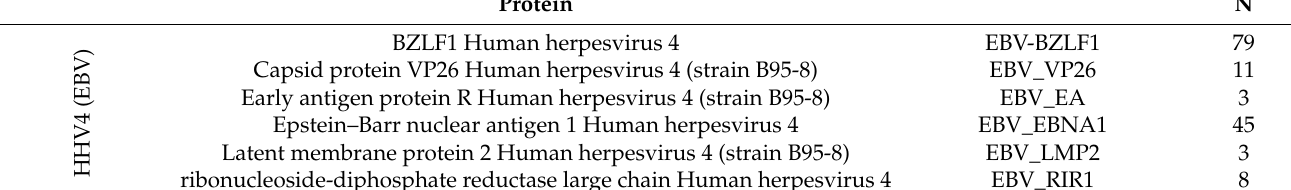
Table 3. Viral (bacterial) antigen epitopes, of which the linear fragments are included in the study. Protein